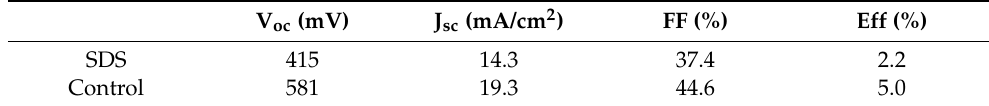
Table 2. Solar cell parameters of the best SDS and control solar cells.